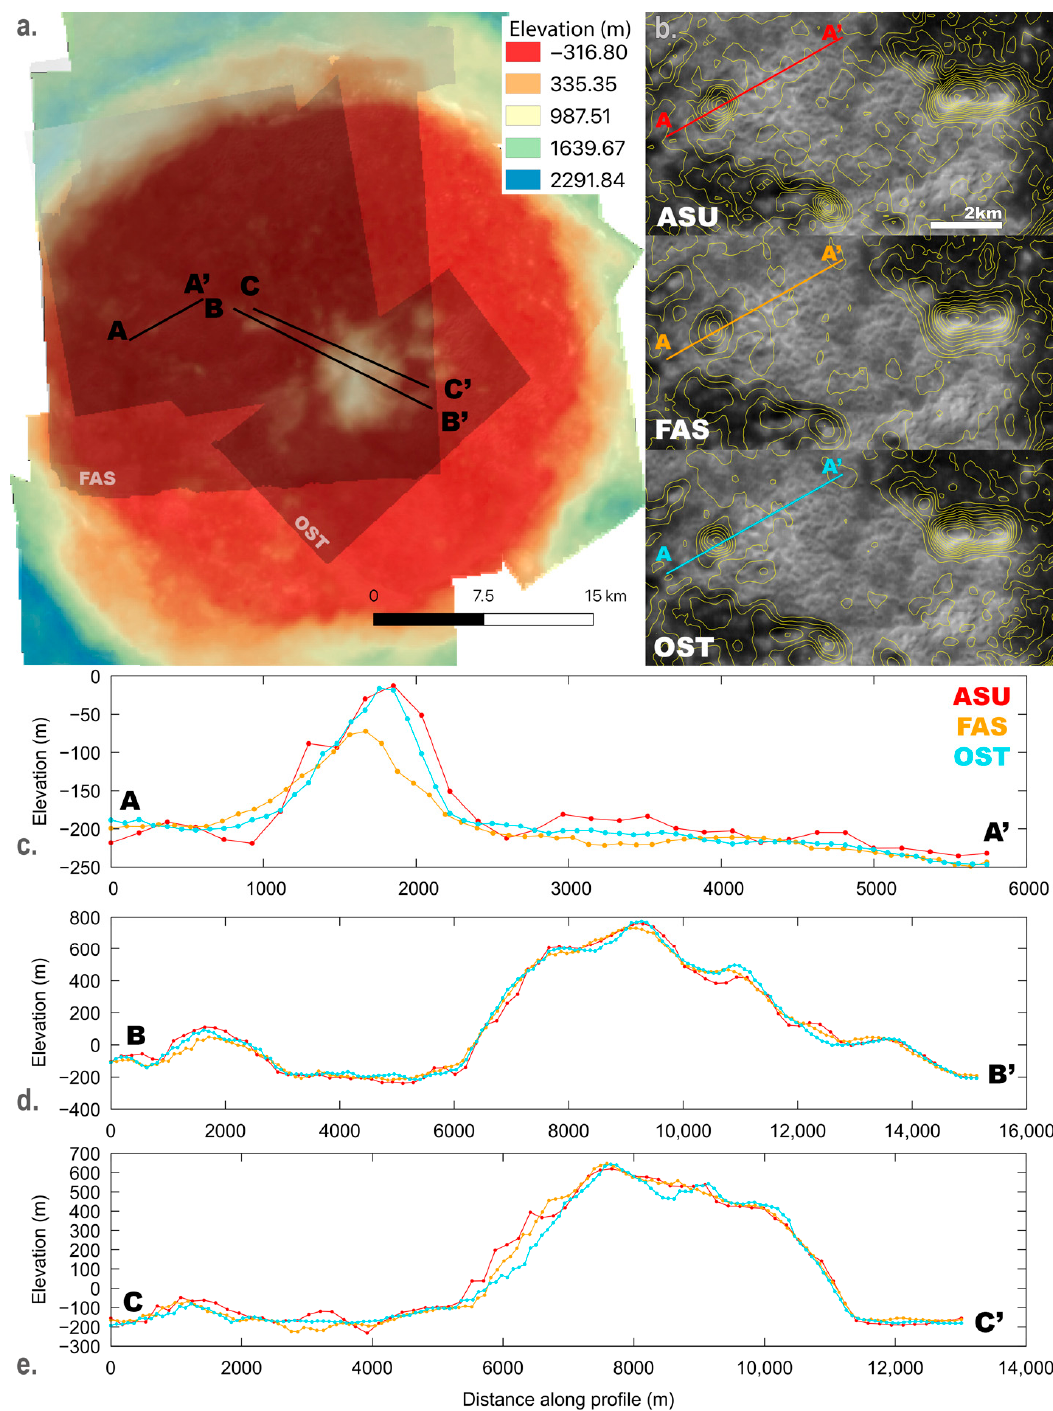
Figure 8. Sander crater topographic profiles. ( a ) Colorized elevation map of ASU (SANDRMS; 162 m/px). Gray polygons show the extents of FAS (90 m/px) and OST (80 m/px); both have been aligned to ASU. ( b ) ASU, FAS, and OST displayed as 30 m contours overlaid on an ASU orthophoto. ( c – e ) DEM elevations for profiles A, B, and